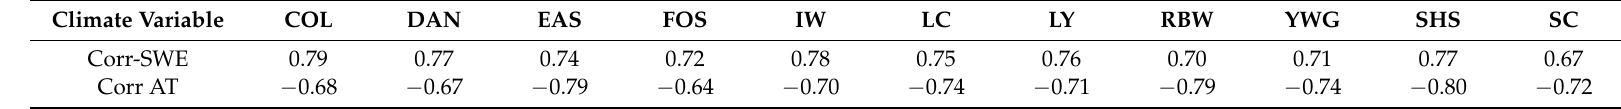
Table 4. Cross-correlation of annual balance on the North Cascade glaciers from 1984 to 2014, except for the Sholes Glacier (SHS) and the Easton Glacier (EAS) from 1990 to 2014. The South Cascade Glacier (SC) has been observed by the USGS from 1985 to 2012. Accumulation season precipitation is the mean April 1 SWE from six SNOTEL stations (Fish Lake, Lyman Lake, Park Creek, Rainy Pass, Stevens Pass, and Stampede Pass. Ablation season temperature is from Diablo